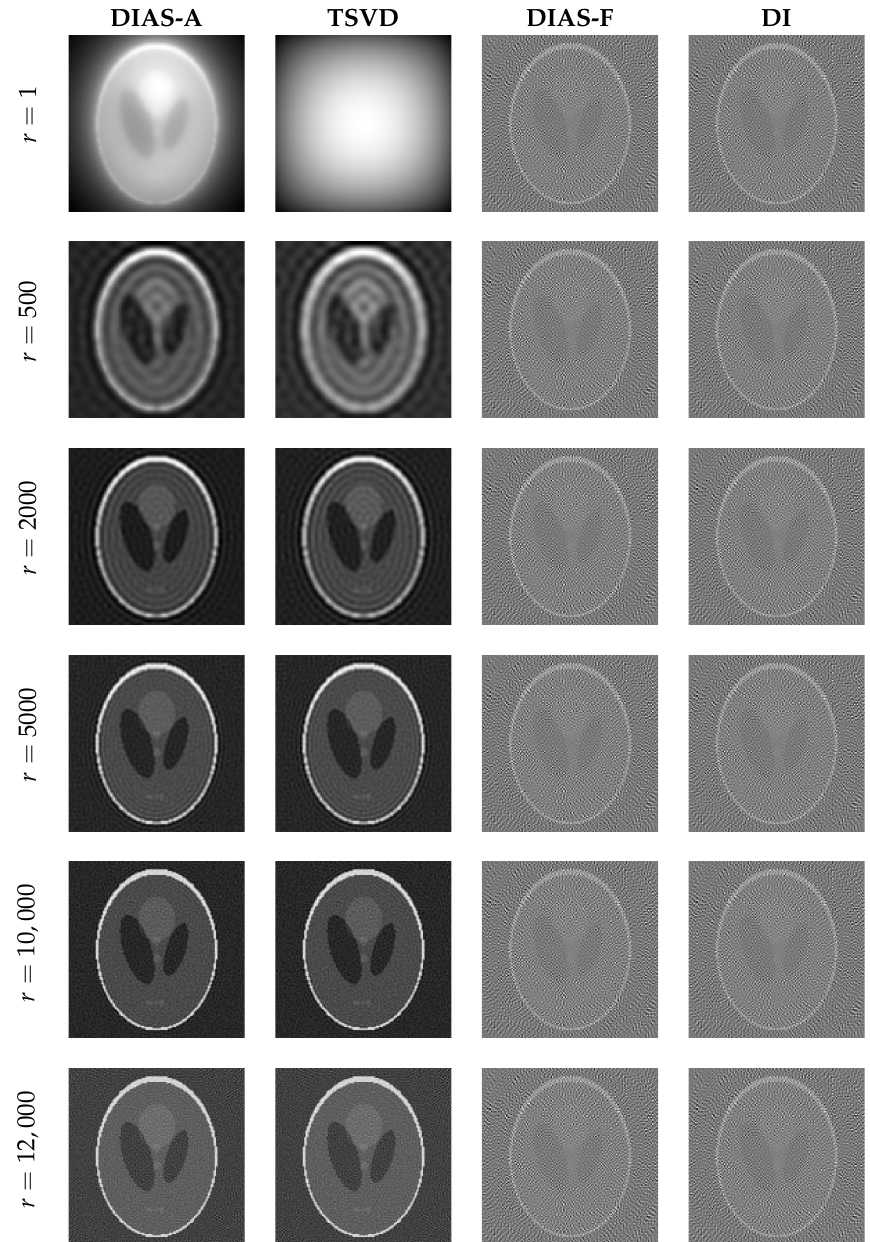
Figure 13. DIAS solutions for X-ray tomography problem with underregularization parameter α = 10 2 , noise level